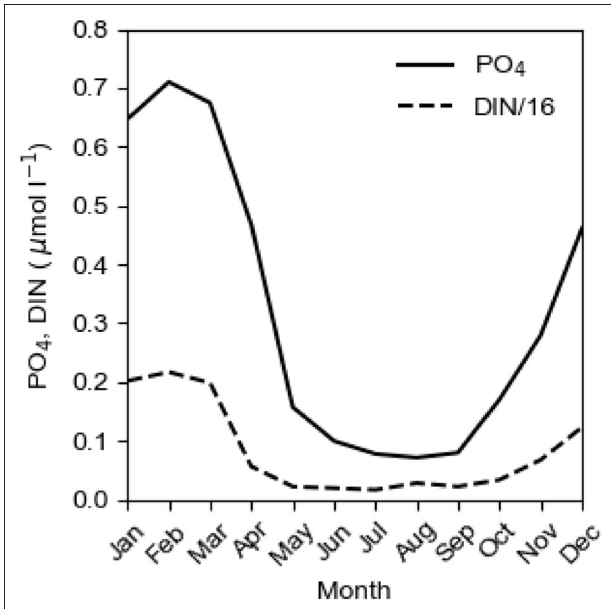
FIGURE 3 | The mean seasonal cycles of PO4 and DIN/16 at the sea surface (0m) at BY 15 in the East Gotland Basin in the period 2004–2018. Data from SMHI (2020).